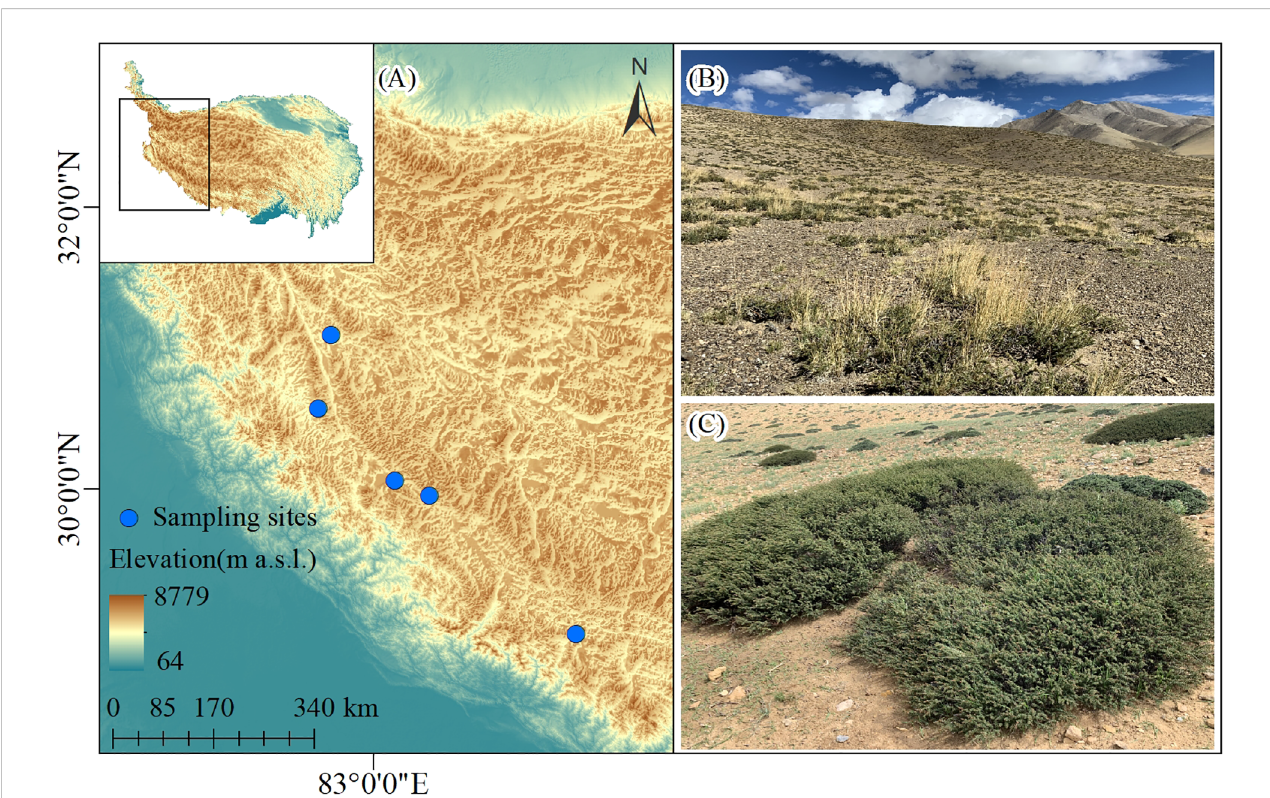
FIGURE 1 (A) A map showing the study area and sampling sites. Photos of the (B) Caragana versicolor community landscape and (C) shrub individuals in drylands of Tibetan